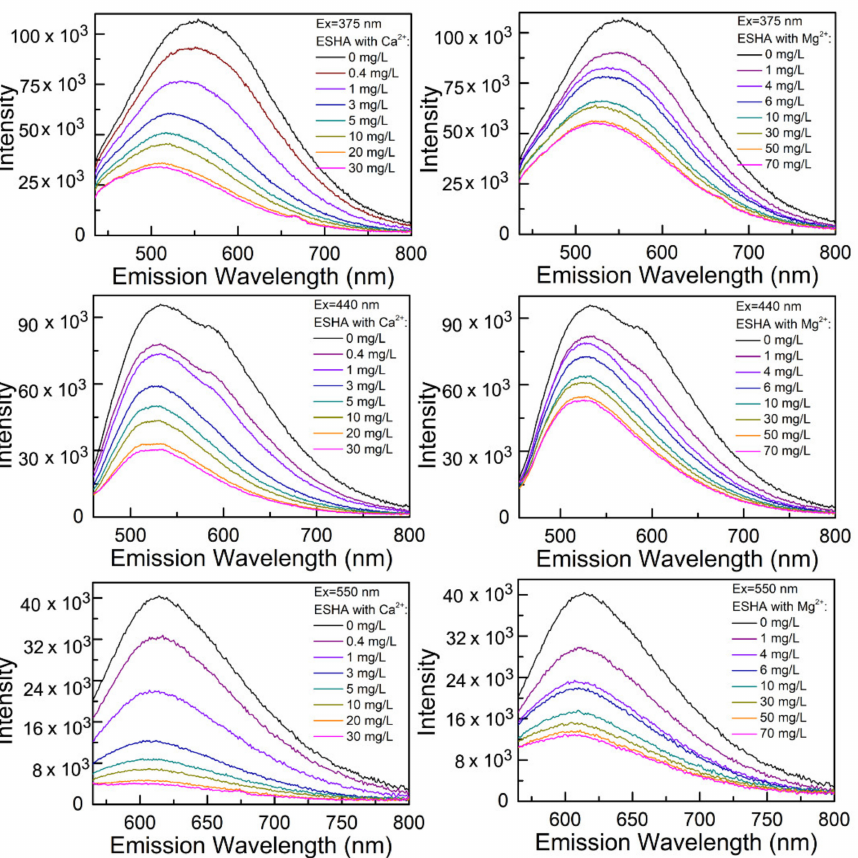
Figure 2. Effects of Mg 2+ and Ca 2+ concentration on the steady-state fluorescence spectra of ESHA (10 mg C/L) aqueous solution at the excitation of 375, 440, and 550 nm.